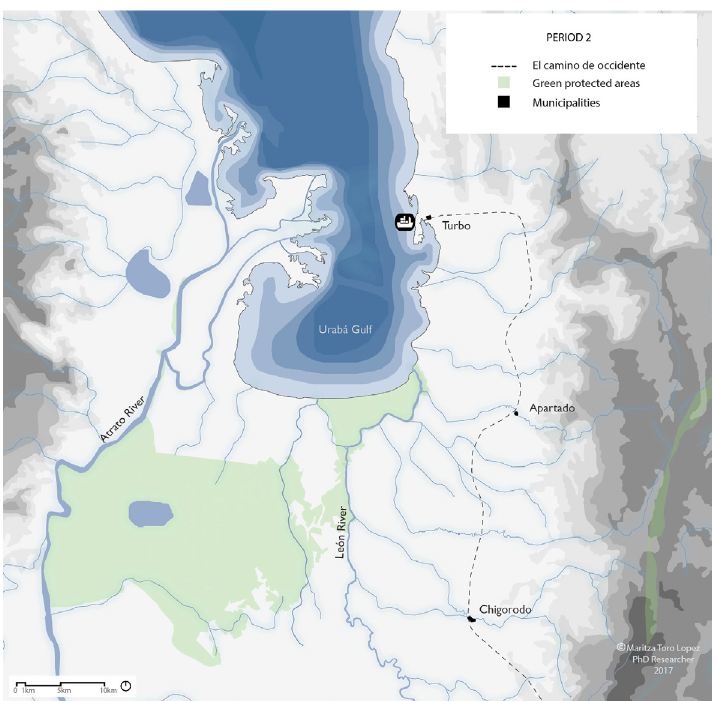
Fig. 3 . Period 2: Tagua exploitation led to the emergence of the municipality of Apartadó. Source: own